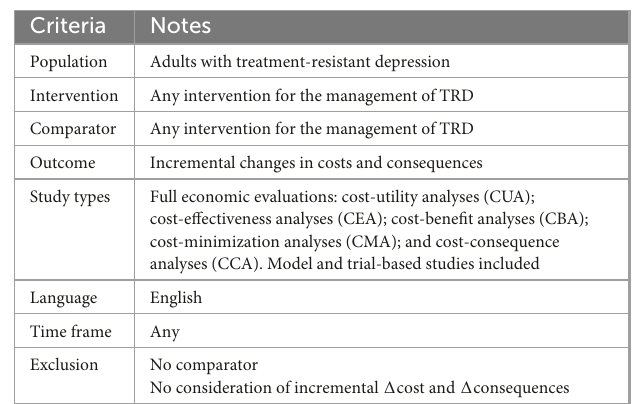
TABLE 1 Review inclusion